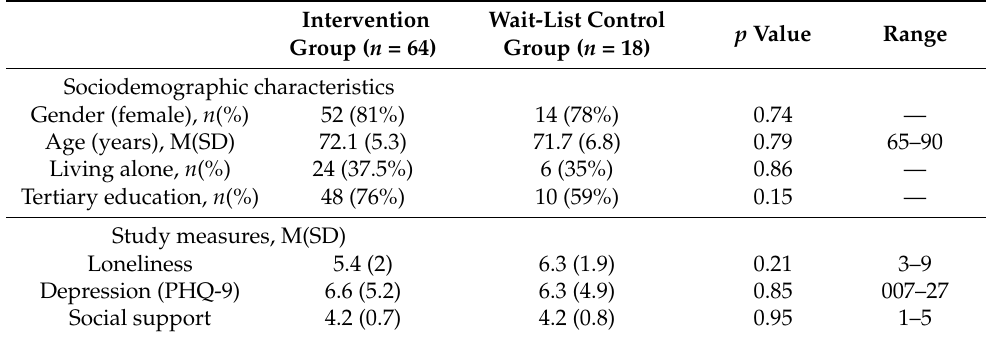
Table 1. Baseline characteristics of the sample.